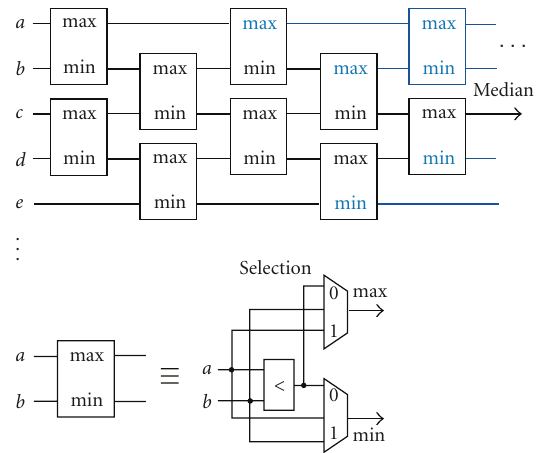
Figure 5: Ordering circuit for the implementation of a median filter. Elements shown in blue are redundant for the selection of the median.